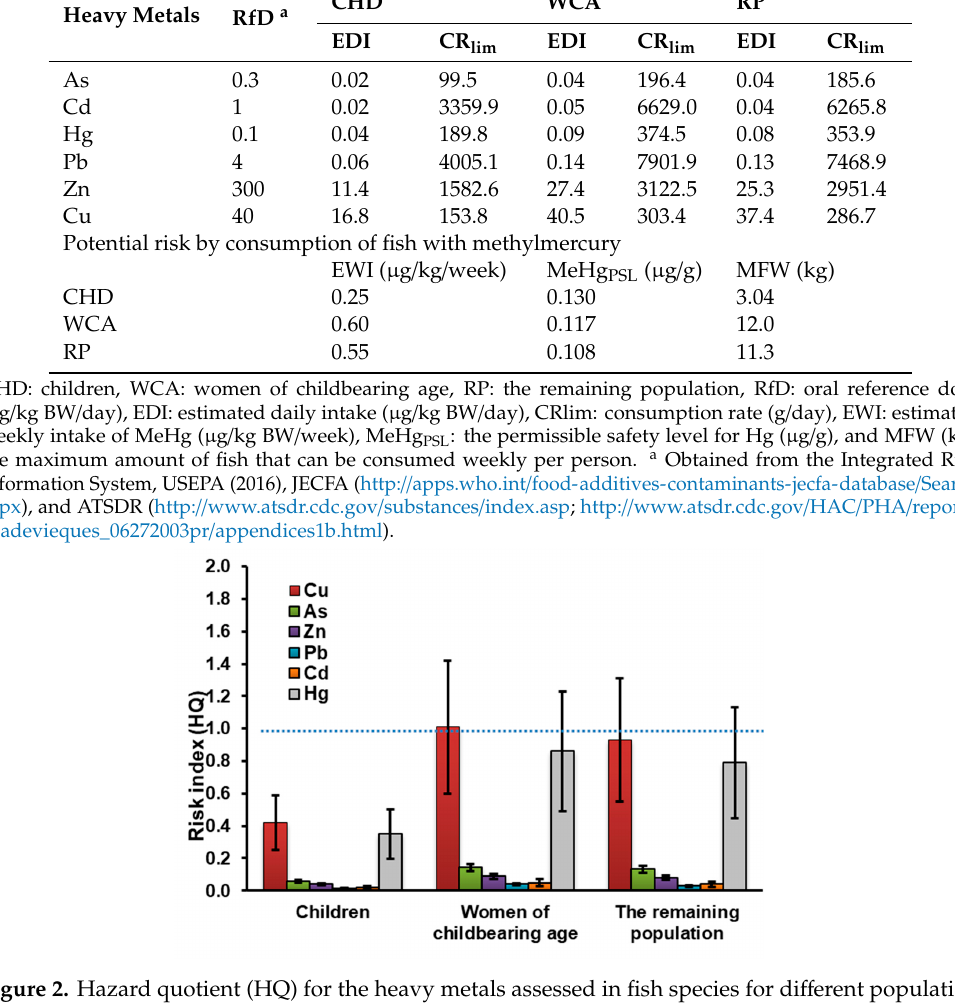
Figure 2. Hazard quotient (HQ) for the heavy metals assessed in fish species for different population groups.